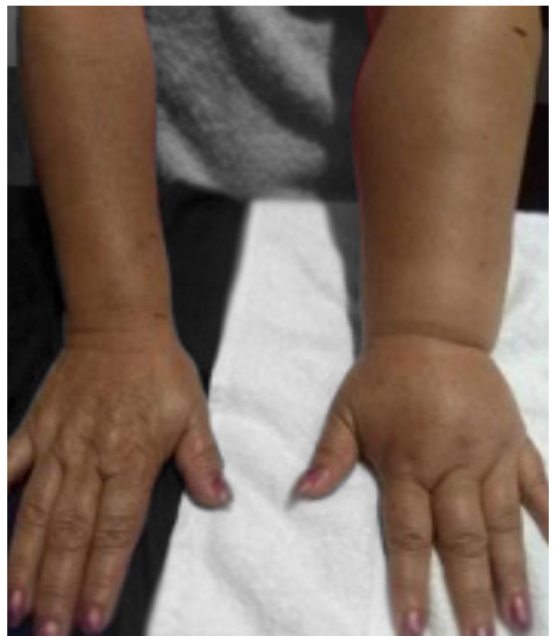
Figure 1. Secondary lymphedema caused by mastectomy with